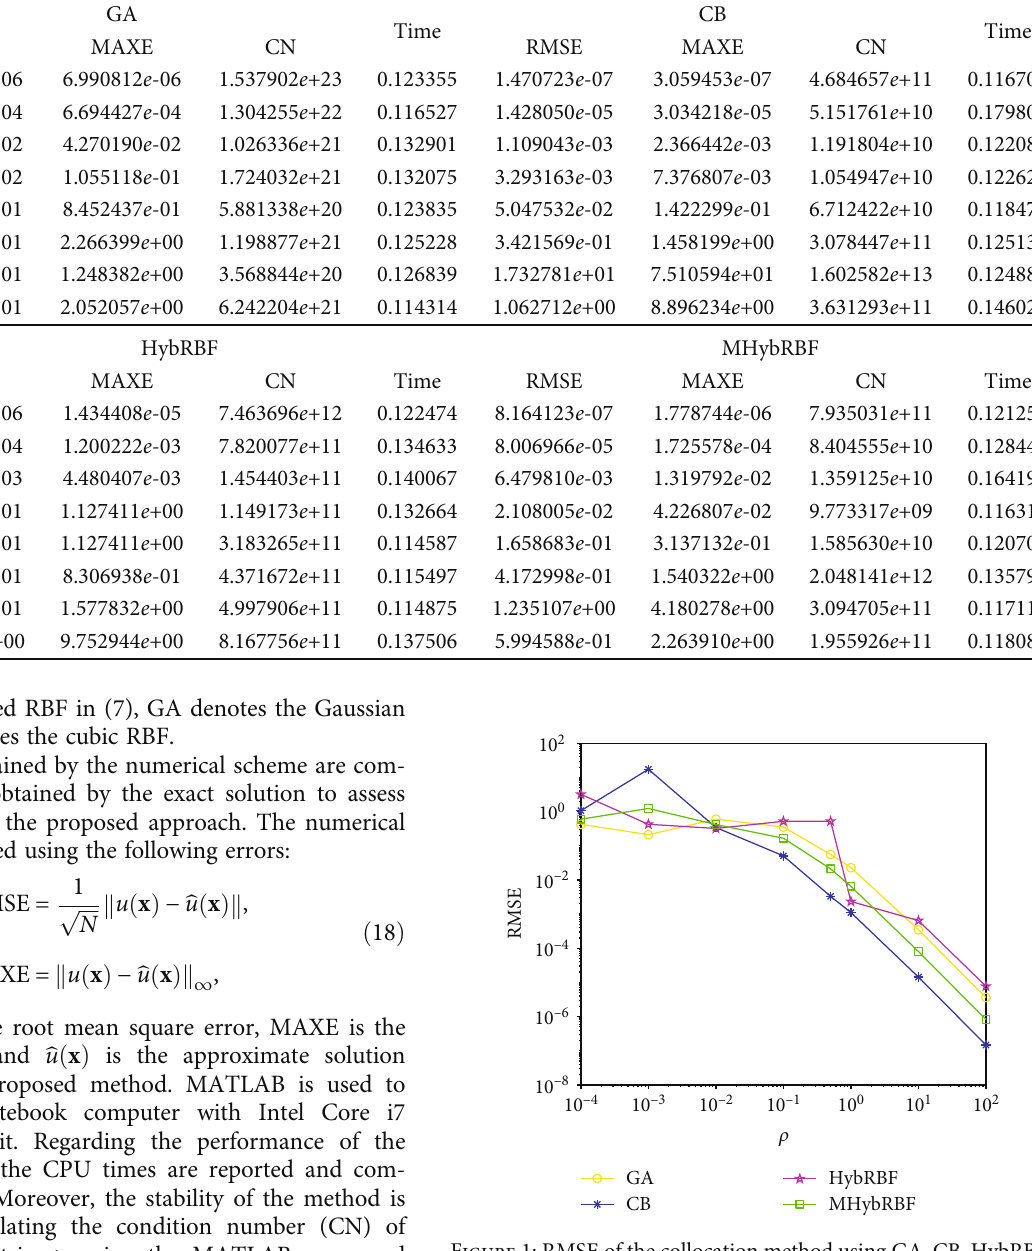
Figure 1: RMSE of the collocation method using GA, CB, HybRBF, and MHybRBF with di ff erent ρ